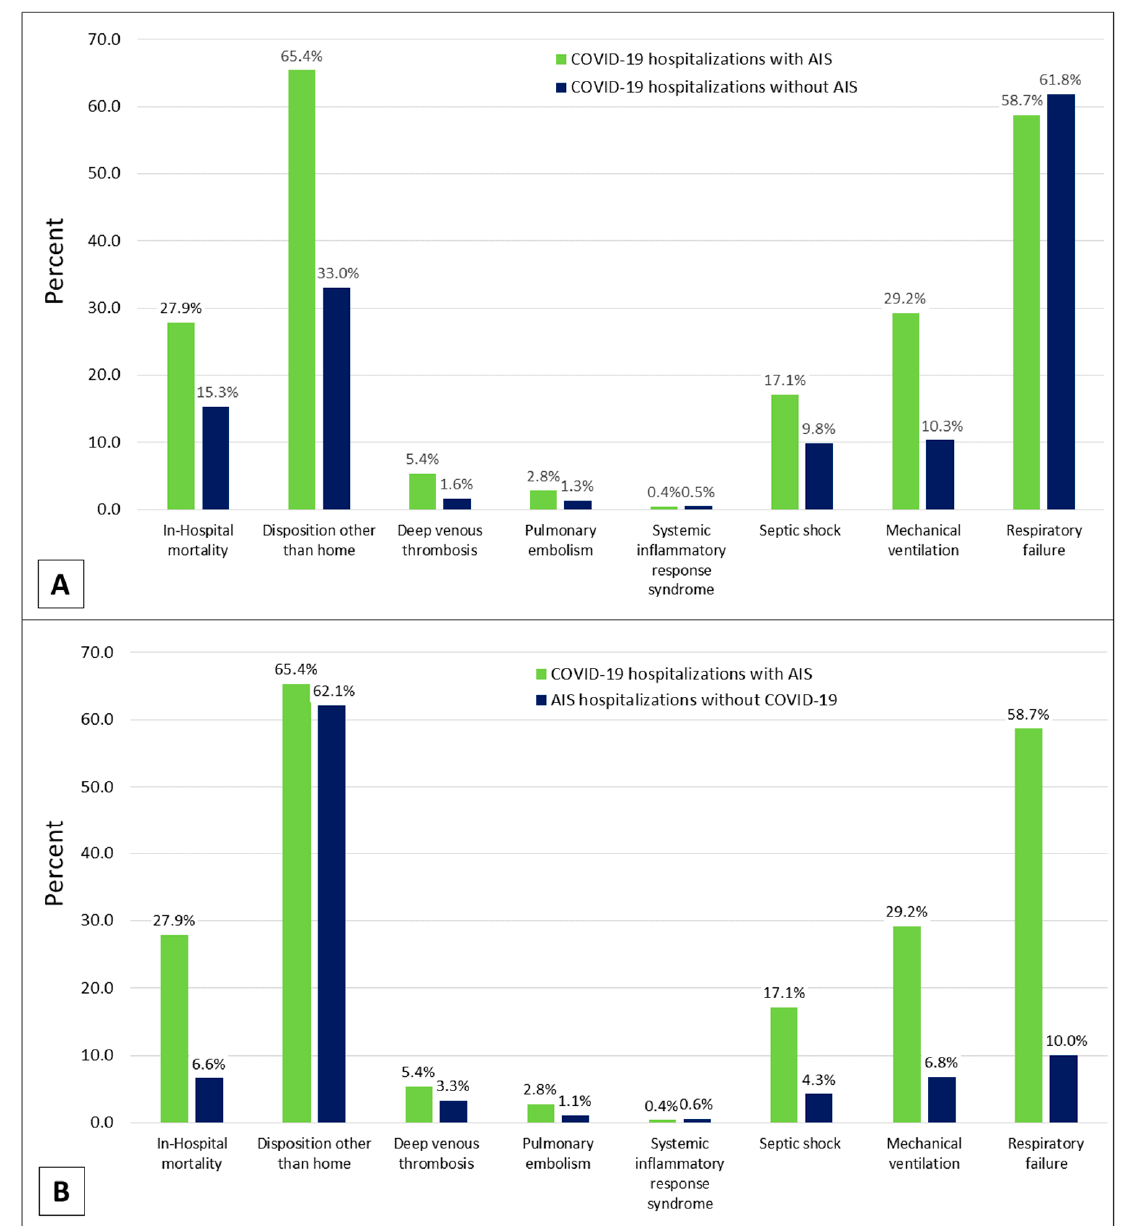
Figure 1. Comparison of adverse hospital outcomes between ( A ) COVID-19 hospitalizations with AIS and COVID-19 hospitalizations without AIS and between ( B ) COVID-19 hospitalizations with AIS and AIS hospitalizations without COVID-19. Likewise, in-hospital mortality (27.9% versus 6.6%, p < 0.001), DVT (5.4% versus 3.3%, p = 0.022), pulmonary embolism (2.8% versus 1.1%, p = 0.004), septic shock (17.1% versus 4.3%, p < 0.001), mechanical ventilation (29.2% versus 6.8%, p < 0.001), and respira- tory failure (58.7% versus 10.0%, p < 0.001), were significantly higher among COVID-19 hospitalizations with AIS, compared to AIS hospitalizations without COVID-19 (Figure